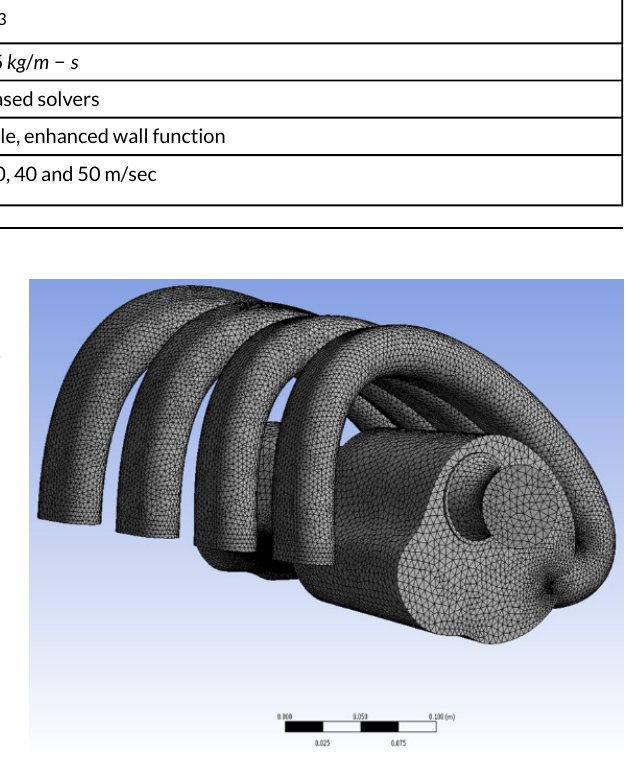
Fig. 4. Mesh Model for Air intake manifold